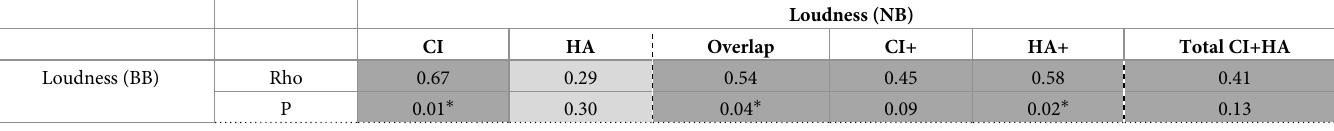
within the same property (CI, HA, Overlap, CI+, HA+ and Total CI